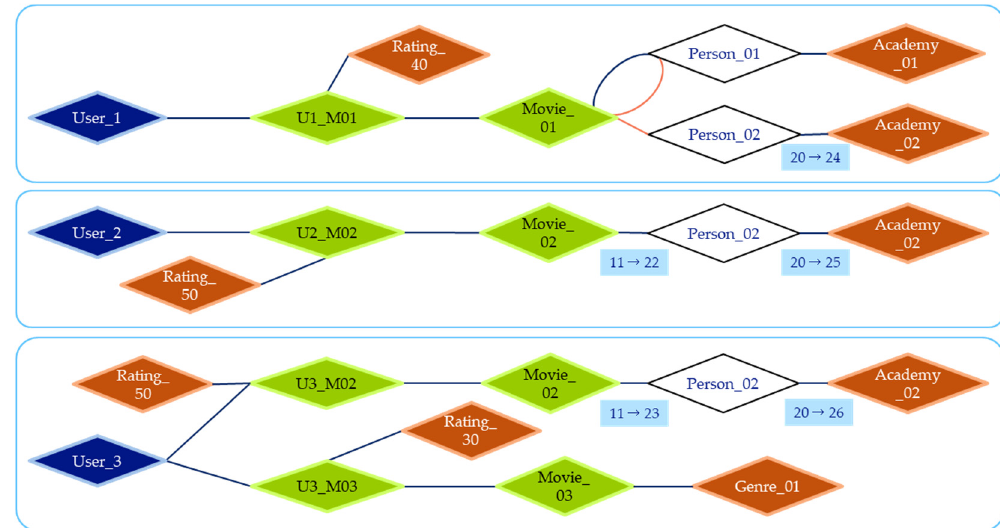
Figure 9. Unit subgraphs after restructuring.